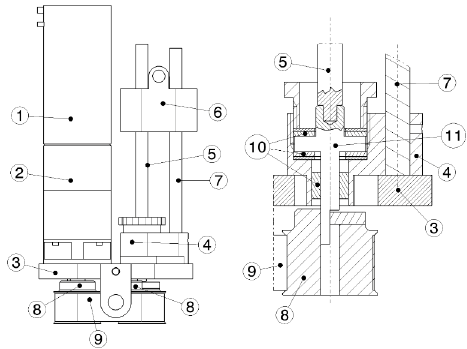
Figure 7. Details of the actuator/transmissions system: (1) rotary motor; (2) gearbox (1st transmission); (3) base plate; (4) screw frame; (5) roller screw (3rd transmission); (6) moving slider; (7) guide bar; (8) transmission pulleys (2nd transmission); (9) belt; (10) bearings; (11) axial loads frame.